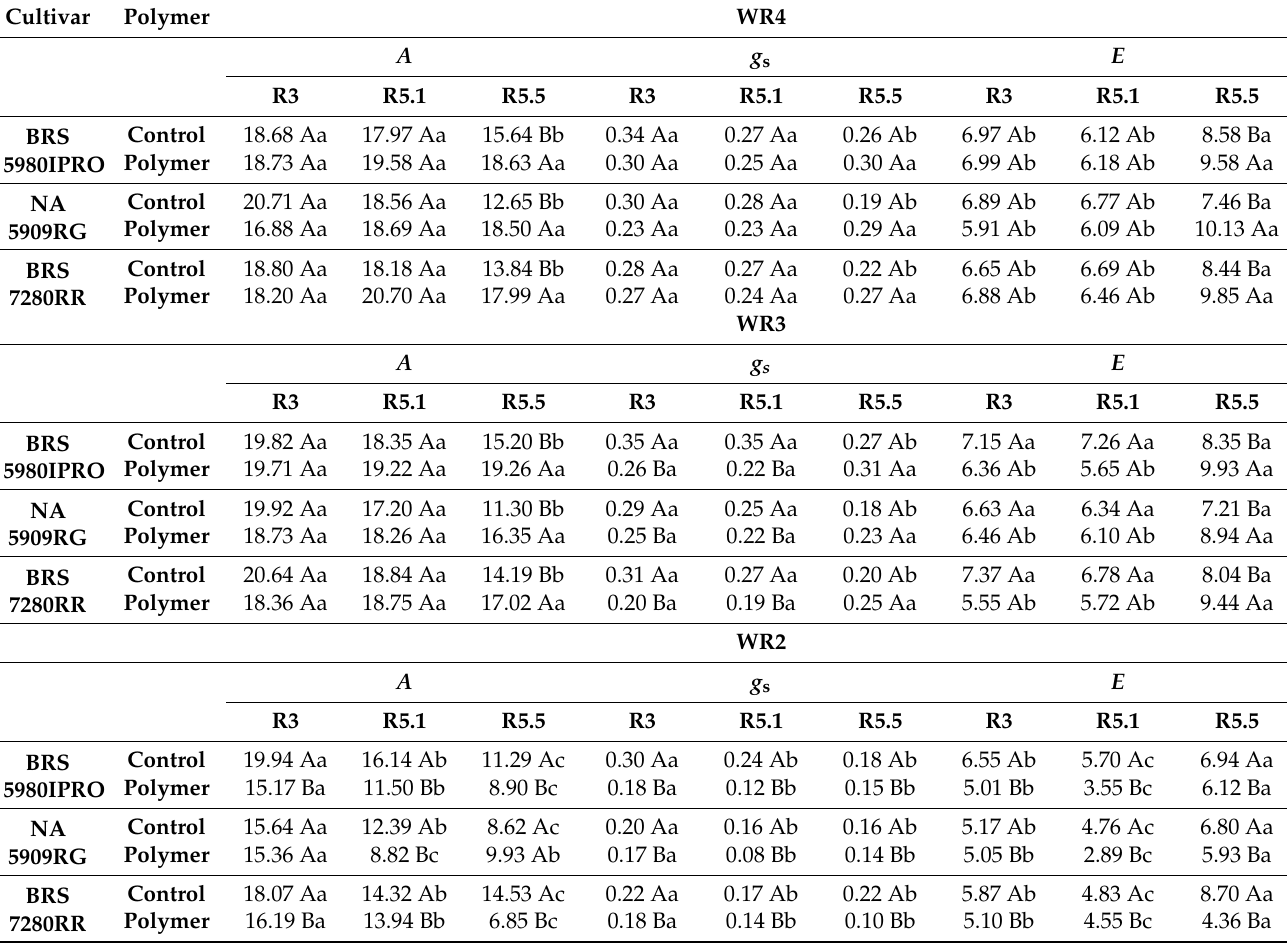
Table 3. Photosynthesis ( A ), stomatal conductance ( g s ) and transpiration ( E ) in three phenological stages of soybean cultivars for control and polymer treatments, in